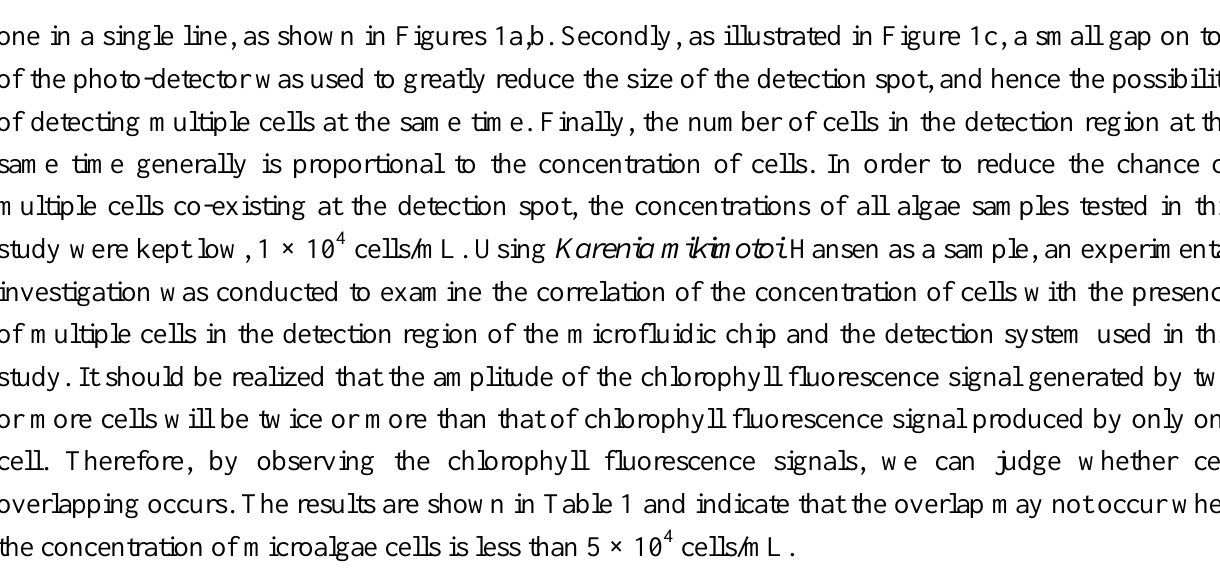
Table 1. The cell overlap as a function of the concentration of microalgae cells.